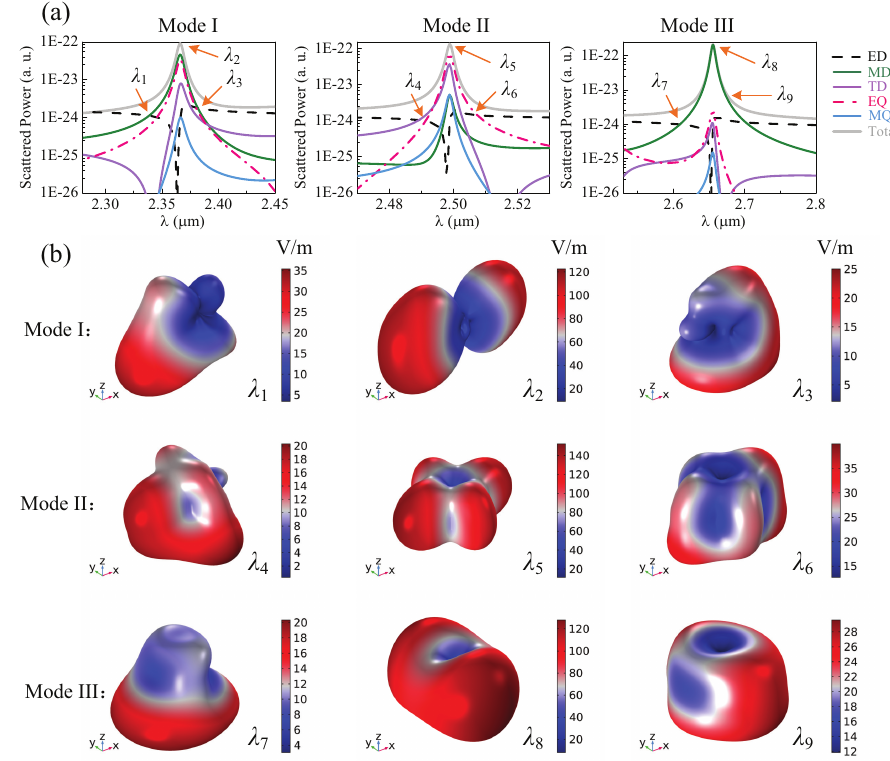
Figure 4. ( a ) The calculated scattered power of different multipoles for modes I, II, and III. ( b ) Radia- tion patterns of the unit cell at different wavelengths. Here, d = 200 nm and r = 200